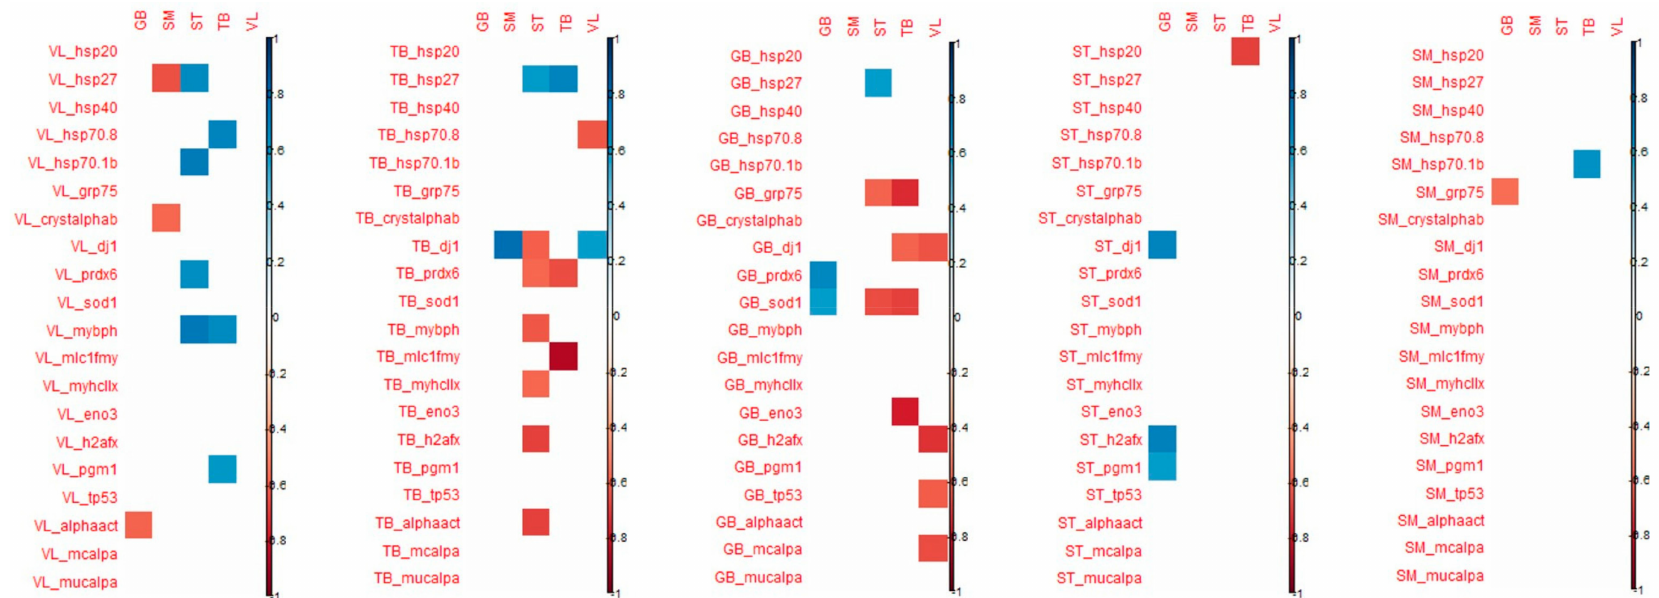
Figure 5. Correlations demonstrated between the shear force of each of the 5 muscles (in columns) and the 20 biomarkers of each muscle (in lines). Only the coe ffi cients that were significant (corresponding to those that were superior or equal to 0.55 / inferior or equal to − 0.55) are indicated (positive correlations in blue and in negative ones